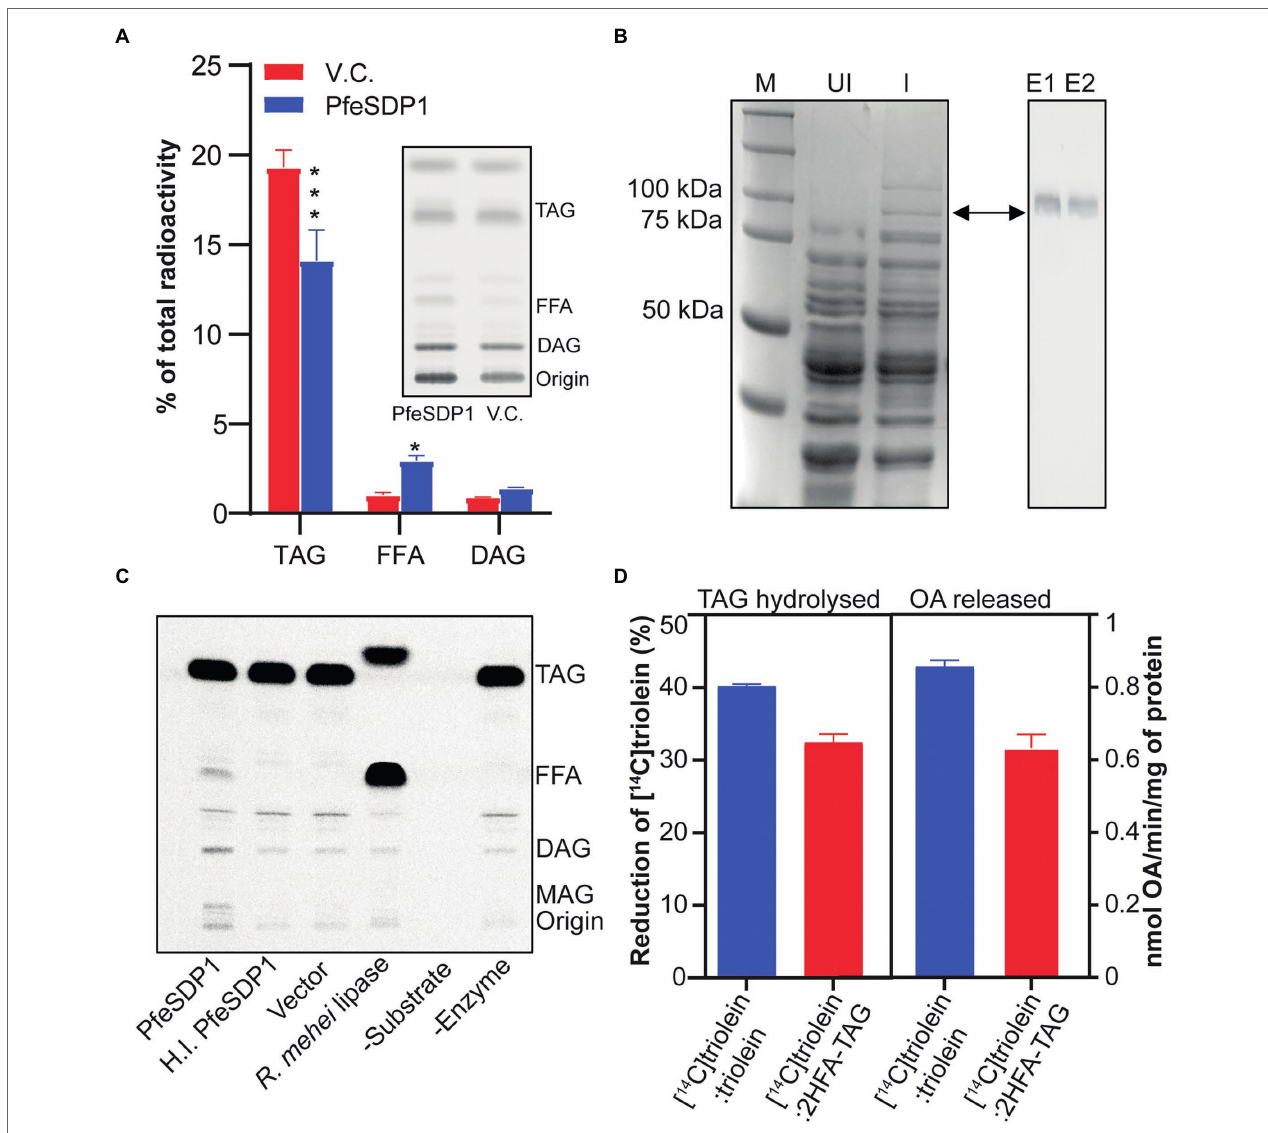
FIGURE 2 | Characterization of PfeSDP1 triacylglycerol lipase activity. (A) PfeSDP1 overexpressed in S. cerevisiae and in vivo metabolic labeling with [ 14 C]acetate to label fatty acid synthesis. The relative amount of radioactivity in TAG, FFA, and DAG neutral lipids quantified by thin-layer chromatography (TLC) separation and phosphor imaging (inset). (B) Purification of a His-tagged PfeSDP1 (96 KDa) expressed in S. cerevisiae . Left, SDS-PAGE of total protein from uninduced (UI) cells and induced (I) cells. M, protein marker. Right, Western blot with anti-(His)6 antibody from E1 and E2, elution fractions of purified protein from Ni-NTA column. (C) TAG lipase activity of purified PfeSDP1 protein. Phosphor image TLC of in vitro lipase assay reactions with [ 14 C]triolein as substrate. Lipase from Rhizopus mehei was used as positive control. Elution fraction from vector control (VC), heat inactivated (HI.) PfeSDP1 and no enzyme addition was used as negative controls. (D) Competitive lipase assay of PfeSDP1 protein with equimolar amounts (1:1) of [ 14 C]triolein:[ 12 C]triolein, or [ 14 C]triolein:[ 12 C]2HFA-TAG as substrates. Lipase activity was represented as amount (%) of [ 14 C]triolein degraded (left) and release of [ 14 C]oleic acid (right) as measured by phosphor imaging. TAG, triacylglycerol; FFA, free fatty acids; DAG, diacylglycerol; ST, sterol; MAG, monoacylglycerol; PL, phospholipids; OA, oleic acid. All the values are represented as Mean ± SD of three independent experiments and significant difference between wild-type control and PfeSDP1 knock-down lines was determined using two-way ANOVA (*** p ≤ 0.001 and * p ≤